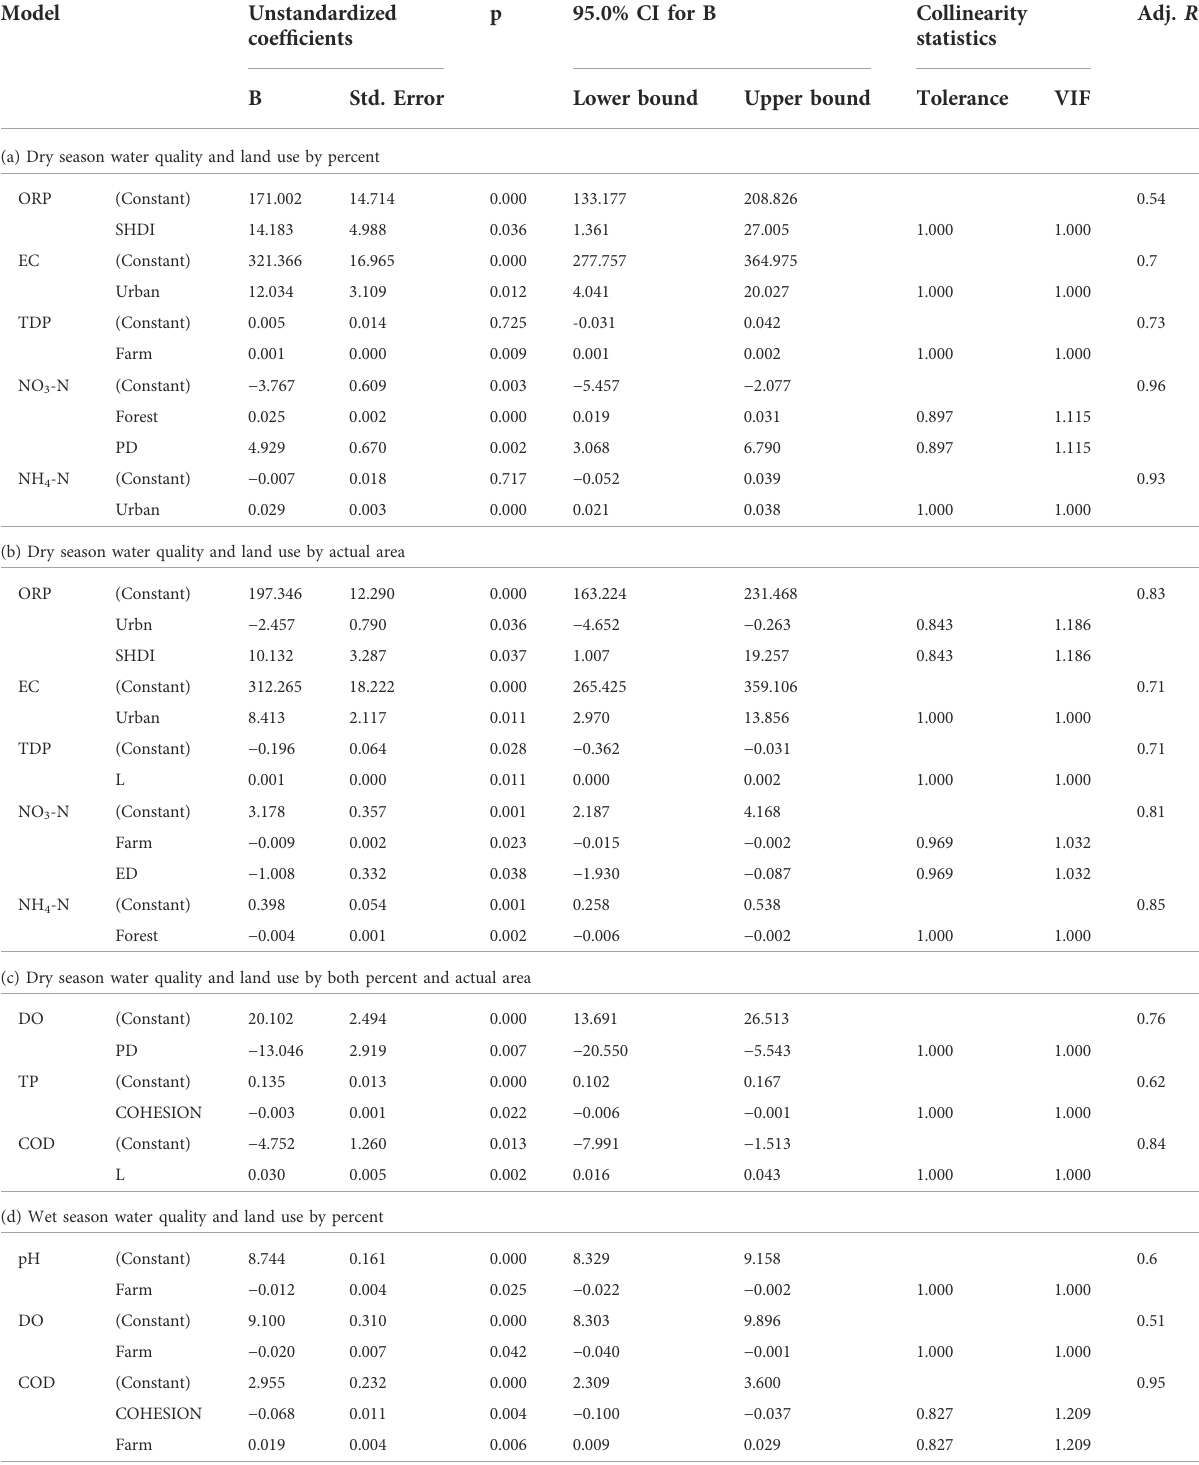
TABLE 3 Water quality parameter models developed from land use types and landscape metrics (50 m riparian is listed, and others of 200 m riparian and 400 m riparian are listed in supporting